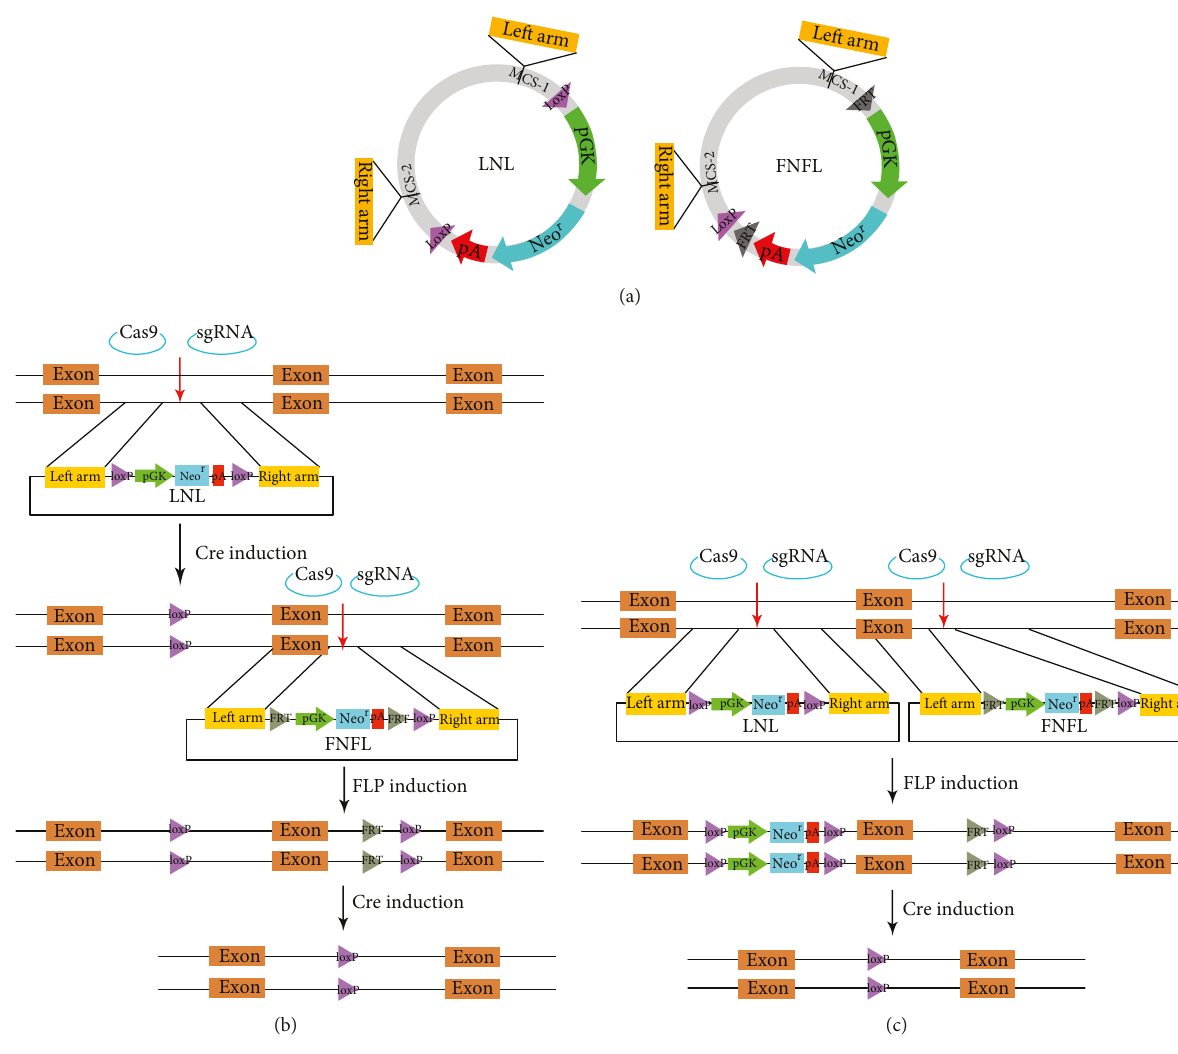
Figure 1: Schematic of CRISPR/Cas9-mediated conditional targeting. (a) Plasmid map of LNL and FNFL vectors. Schematic diagrams of LNL plasmid and FNFL plasmid. LoxP sites are shown by purple arrowheads, and FRT sites are indicated by grey arrowheads. (b) Sequential targeting of LNL and FNFL cassettes in two steps. First, the LNL cassette was inserted to the 5 ′ site of the region intended to delete. And then the neo r cassette was removed upon 4-OHT treatment, with one LoxP site left. Subsequently, the FNFL cassette was inserted to the 3 ′ site of the target region. Next, part of the FNFL cassette was depleted by FRT-FLP recombination upon Dox treatment, with one FRT site and one LoxP site left. Finally, the fl oxed exon was eliminated by Cre-LoxP recombination induced by 4-OHT treatment. LoxP sites and FRT sites are indicated by purple and grey arrowheads, respectively. The CRISPR targeting sites are labelled by red arrows. (c) Simultaneous targeting of LNL and FNFL cassettes in one step. The CRISPR/Cas9 technique was employed to introduce biallelic insertion of LNL and FNFL cassettes to the targeting locus simultaneously. The FNFL cassette was depleted by Dox-inducible FLP-FRT recombination, with one FRT site and one LoxP site being left. Lastly, the LoxP- fl anked genomic region was deleted by 4-OHT treatment to induce